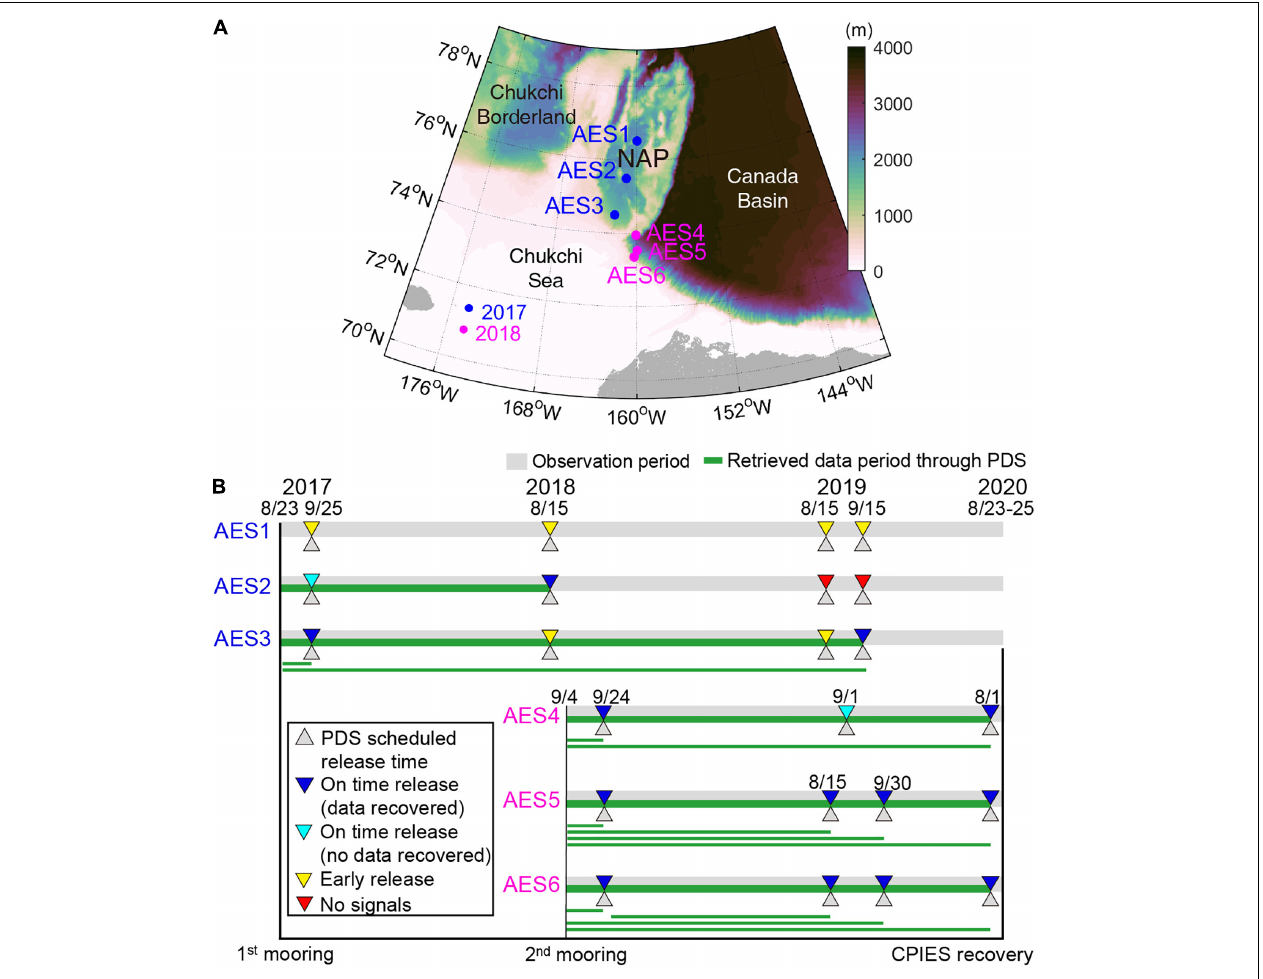
FIGURE 2 | (A) Location of PDS-CPIES deployment in the western Arctic Ocean. Blue and magenta circles indicate locations in 2017 and 2018, respectively. Background colors indicate bathymetry every 100 m. NAP: Northwind Abyssal Plain. (B) Timeline of CPIES observation and PDS operation time. Gray and green lines indicate the duration of CPIES observation and retrieved data period through PDS, respectively. Thin green lines indicate the retrieved data period through individual PDSs. Triangles indicate PDS-related information; gray triangles are the scheduled PDS release time, whereas inverted blue (and cyan) triangles indicate on-time PDS release with success (and failure) of remote data retrieval. Inverted yellow (and red) triangles indicate the failure of on-time release of PDS with early release (and no signals). Substantial system-upgrades addressed problems observed with the 2017 deployment, producing much better performance in